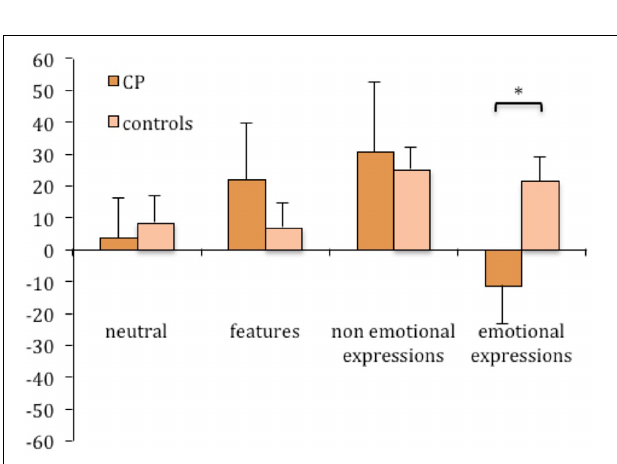
FIGURE 5 | Mean difference between upright and inverted conditions in the percentages of correct responses in the change detection task (task 2) plotted as a function of group and experimental manipulations. Error bars represent standard error of the mean. ∗ Between subjects significant